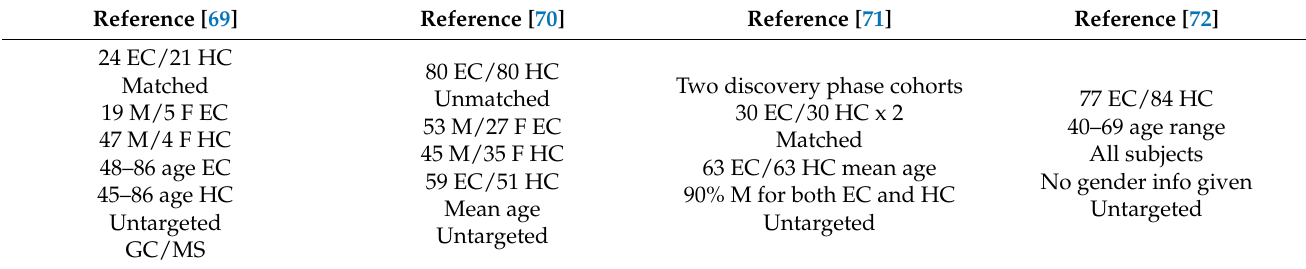
Table 5. Description of patient cohorts and study types used in EC studies.